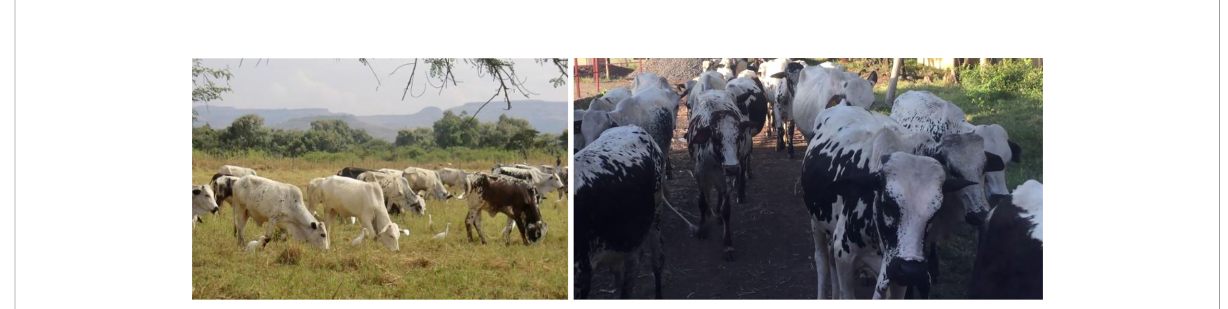
FIGURE 3 Fogera cattle heifers (left) and young bulls (right) at the Andassa Livestock Research Center